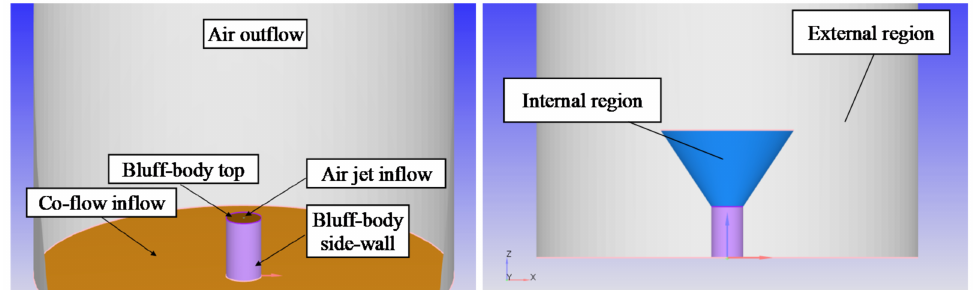
Figure 2. Nonreactive flow simulation computational domain.